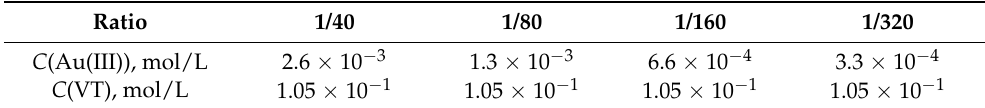
Table 1. The concentrations of VT and Au(III) for different solutions. Ratio 1/40 C (Au(III)),